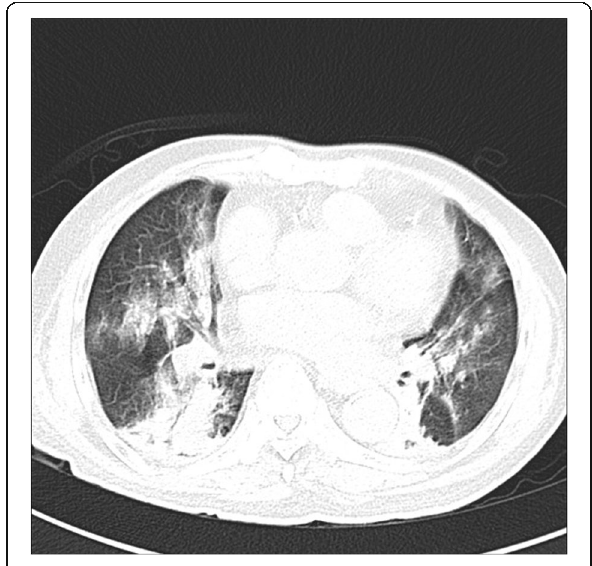
Fig. 3 Chest computed tomography scan showed diffuse pneumonia in both lungs with multifocal ground-glass opacities and crazy paving